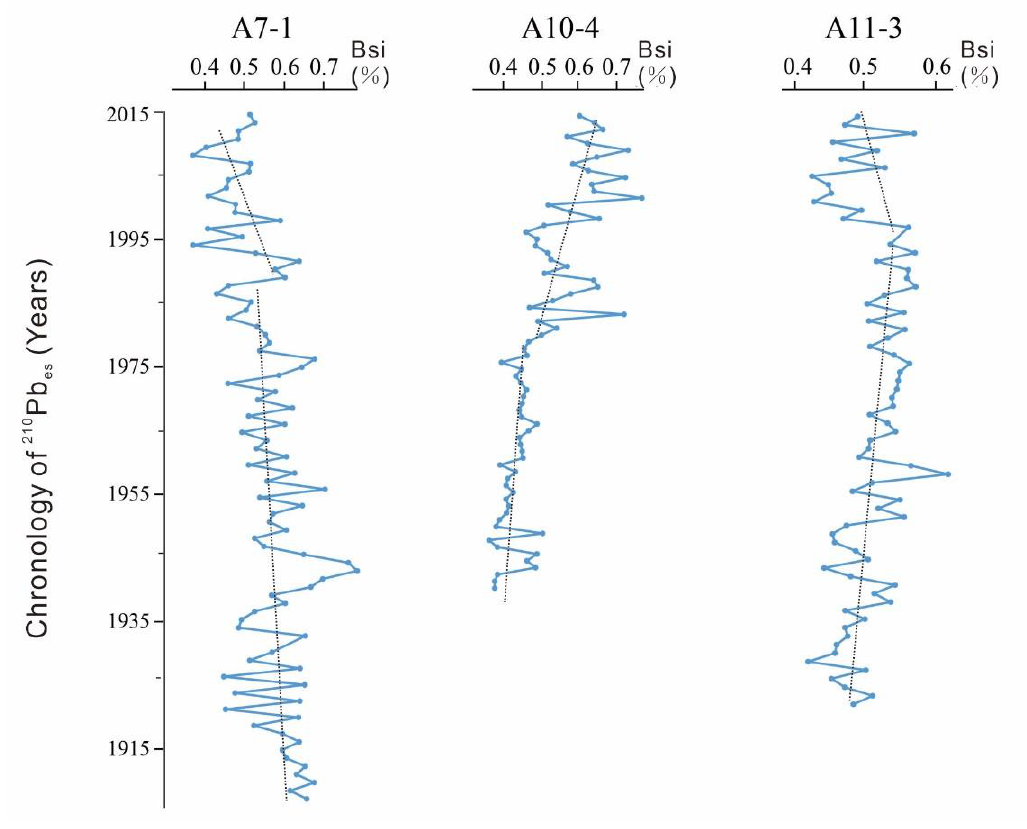
Figure 4. Results of BSi.